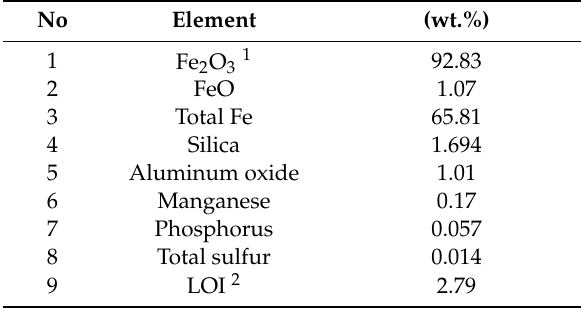
Table 5. Chemical composition of the iron ore.